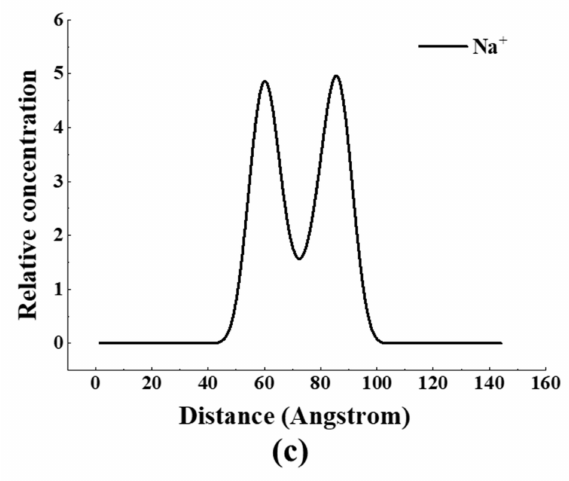
Figure 7. Distribution of cations in different SDS foams. ( a ) 50 g/L CaCl 2 , ( b ) 50 g/L MgCl 2 , and ( c ) 50 g/L